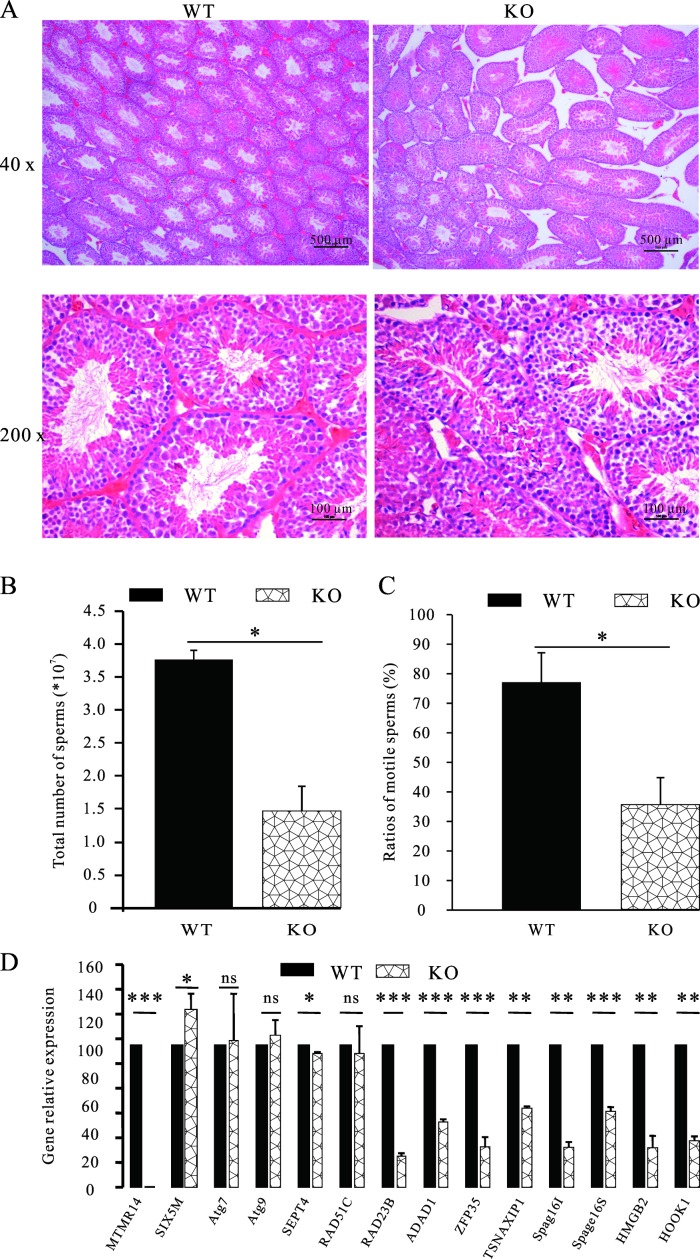
Spermatogenesis was defective in MTMR14-/- mice.(A) Testicular histological sections of WT and MTMR14-/- mice at eight weeks were stained using haematoxylin and eosin. The results of six separate replications were very similar. (B) Age-matched WT and MTMR14-/- male mice were sacrificed to obtain the sperm from both sides of the testes, epididymis, and vas deferens. These sperm were collected and counted. The total number of sperm was reduced in MTMR14-/- mice (n = 8). *: P: <0.05. (C) The ratio of motile sperm in MTMR14-/- mice significantly decreased compared with age-matched WT mice (n = 8). *: P < 0.05. (D) Effects of MTMR14 deficiency on the mRNA expression levels of spermatogenic genes. RT-PCR was performed to detect the relative expression levels of the following genes: SIX5, Atg7, Atg9, SEPT4, RAD51C, RAD23B, ADAD1, ZFP35, TSNAXIP1, Spag16l, Spag16s, HMGB2, and HOOK1. MTMR14 was used as a positive control. *: P <0.05; **: P <0.01; ***: P < 0.001; ns: not significant. These results demonstrated that the deletion of MTMR14 damaged spermatogenesis in mice.